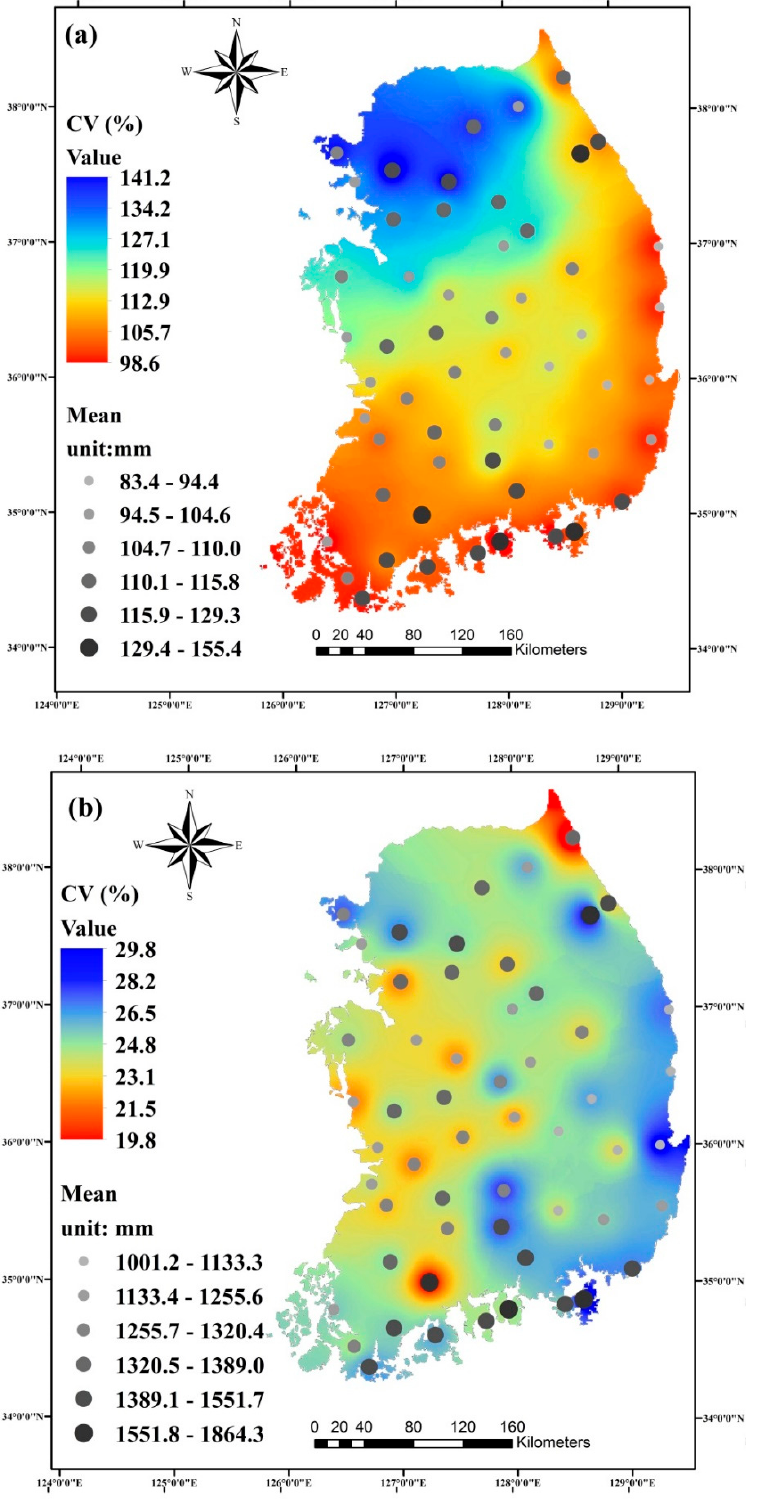
Figure 3. Mean and Coefficient of variation (CV%) for ( a ) monthly precipitation ( n = 432) and ( b ) annual precipitation ( n = 36) at the 55 selected meteorological stations across the South Korea.